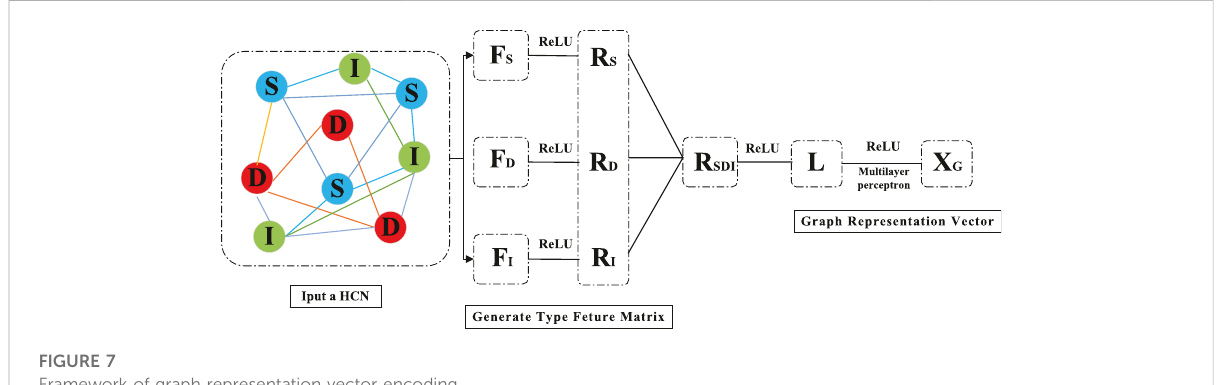
FIGURE 7 Framework of graph representation vector